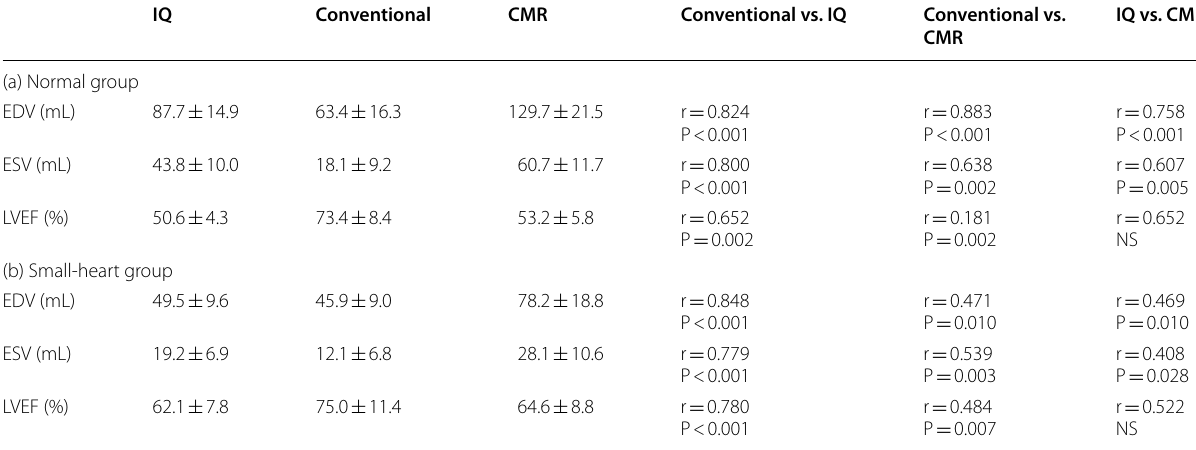
Table 3 Comparison of EDV, ESV, and LVEF determined using conventional SPECT, IQ-SPECT, and CMR